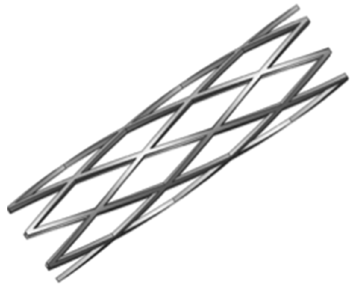
Figure 1. Spherical occlusion device in its initial cylindrical tubing configuration.